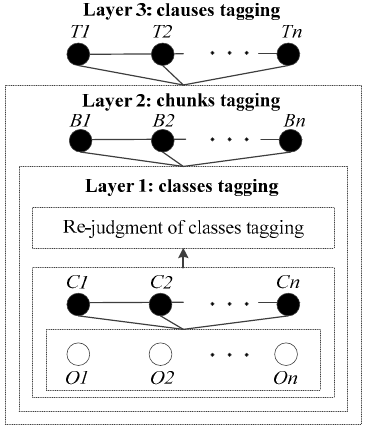
Figure 6. Diagram of cascaded conditional random fields.